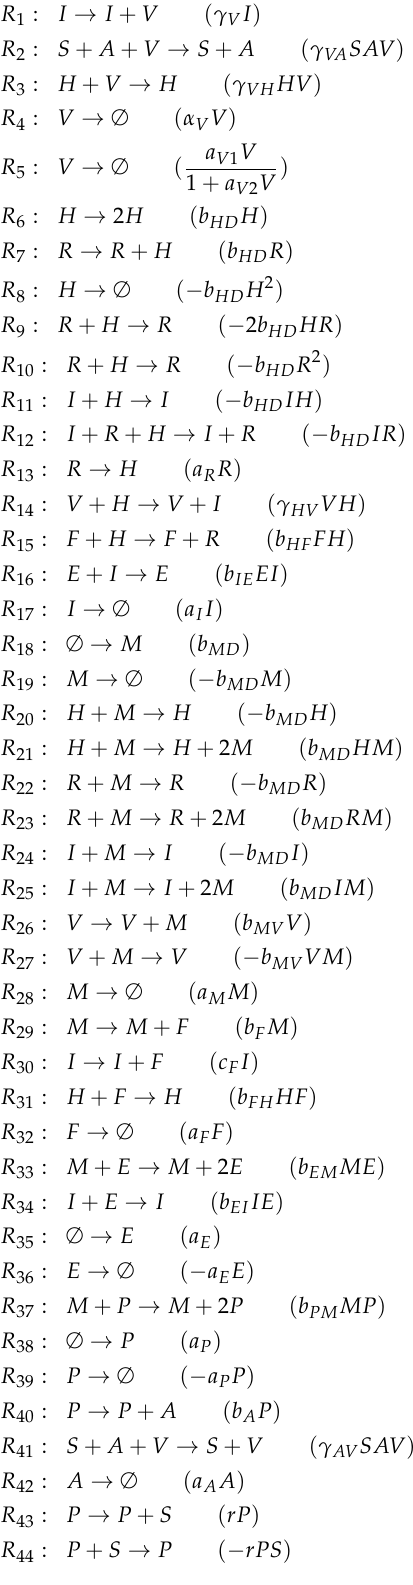
Figure A8. Reactions of Hancioglu model